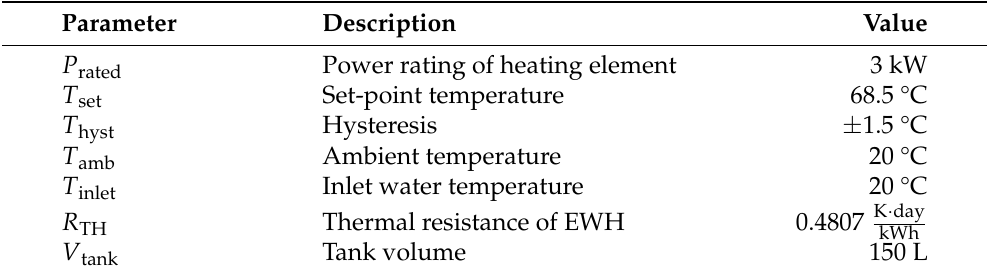
Table 1. EWH parameters used for the baseline energy consumption. Note: K is Kelvin.